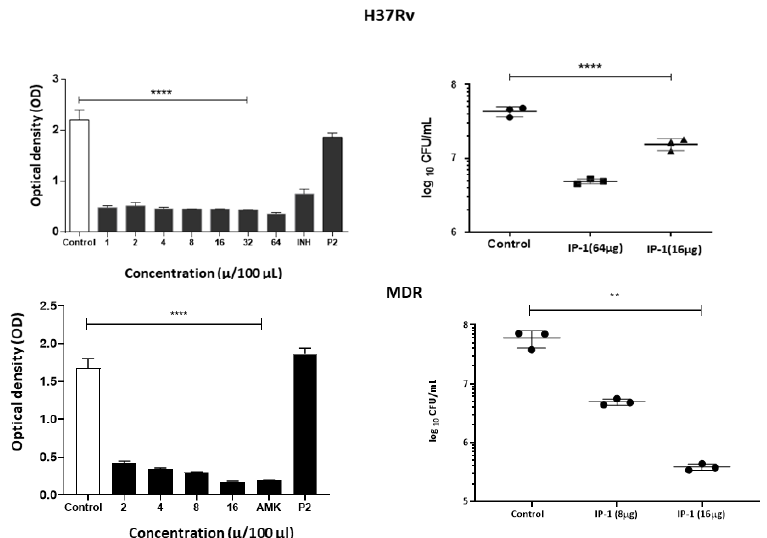
Figure 6. E ff ect of IP-1 against M. tuberculosis (top panel H37Rv, bottom panel MDR strain) in vitro. Left figures show the MICs determined by broth microdilution evaluated by a colorimetric assay using Cell Titer 96 ® Aqueous, and right figures show viability of the bacteria by counting the colony-forming units after treatment with the indicated IP-1 concentrations; each symbol (Triangles, squares, circles) represent an independent determination. All the IP-1 concentrations showed significant activity against mycobacteria, being MDR strain more susceptible to IP-1 and similar to the MIC control that corresponded to amikacin (AMK), an antibiotic for which this strain is highly susceptible, and for drug-sensible H37Rv strain isoniazid (INH) that is the most e ffi cient primary antibiotic. As negative control we include P2, a synthetic peptide derived from arachnid AMP at 64 µ g. Each result is reported as the mean ± SD, asterisk represents statistical significance (** p < 0.003, **** p <